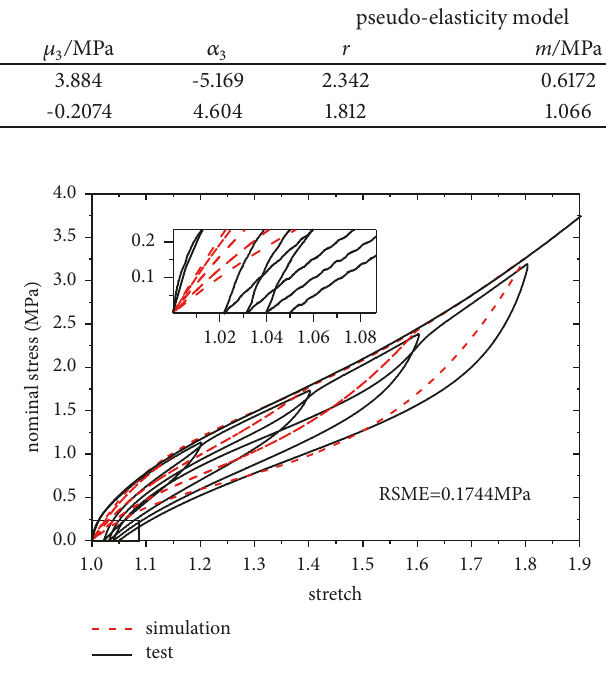
Figure 6: Experimental and simulation results of NSBR7 for the Mullins effect without the permanent